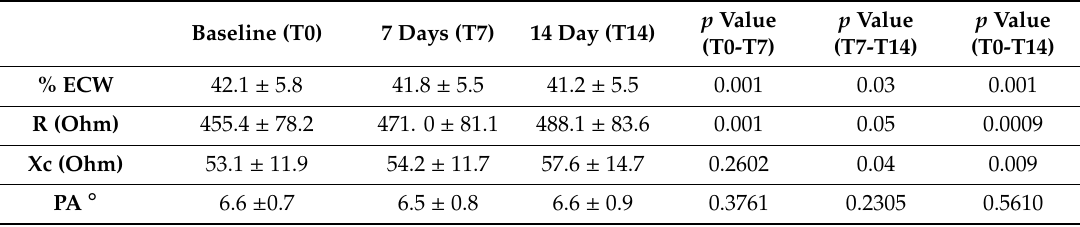
Table 2. BIA (bioimpedance analysis) parameter changes along the exercise program.